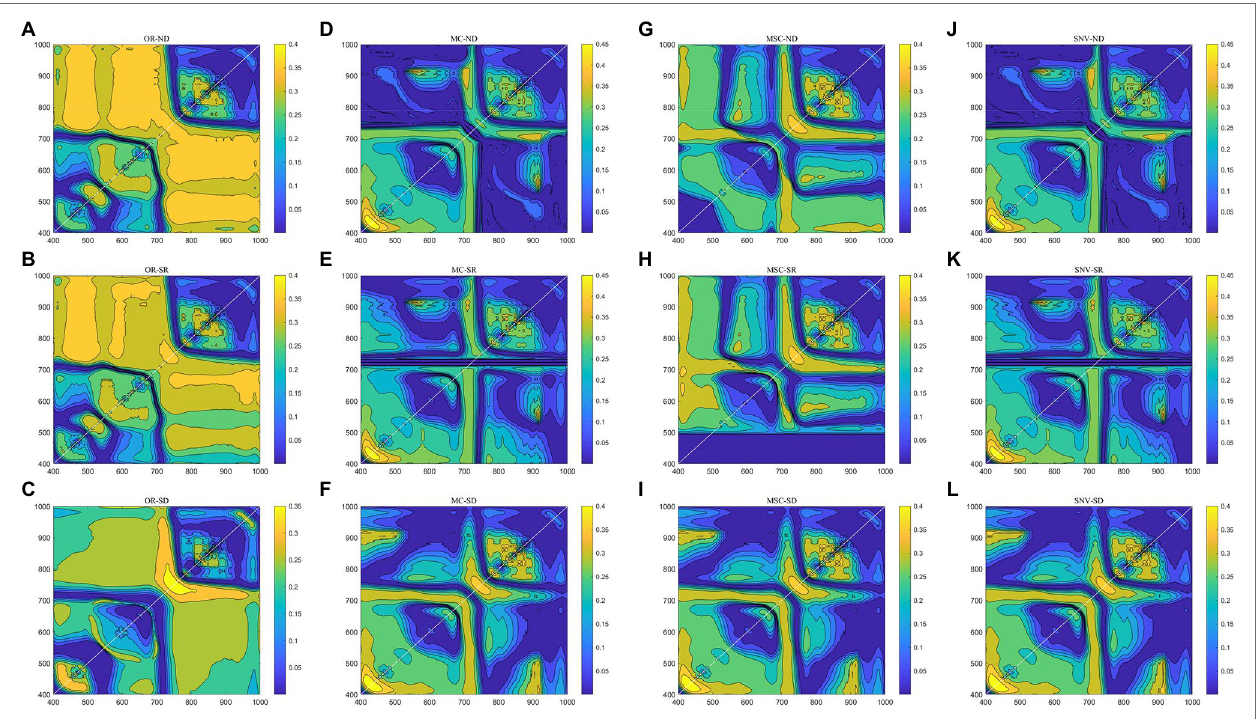
FIGURE 3 | Determination coefficients for optimal two-band combinations with the different spectral variation methods [ A–C for original reflectivity (OR); D–F for mean centralization (MC); G–I for multivariate scattering correction (MSC); and J–L for standard normal variate transform